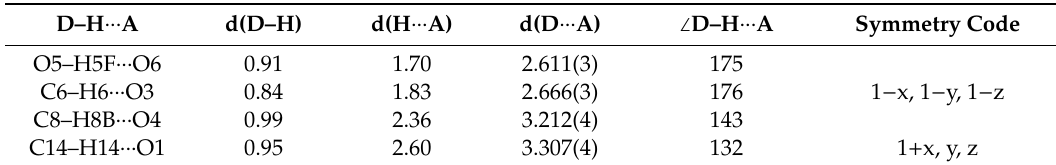
Table 3. Hydrogen bonding interactions (Å, ◦ ) of the Co(II) complex.